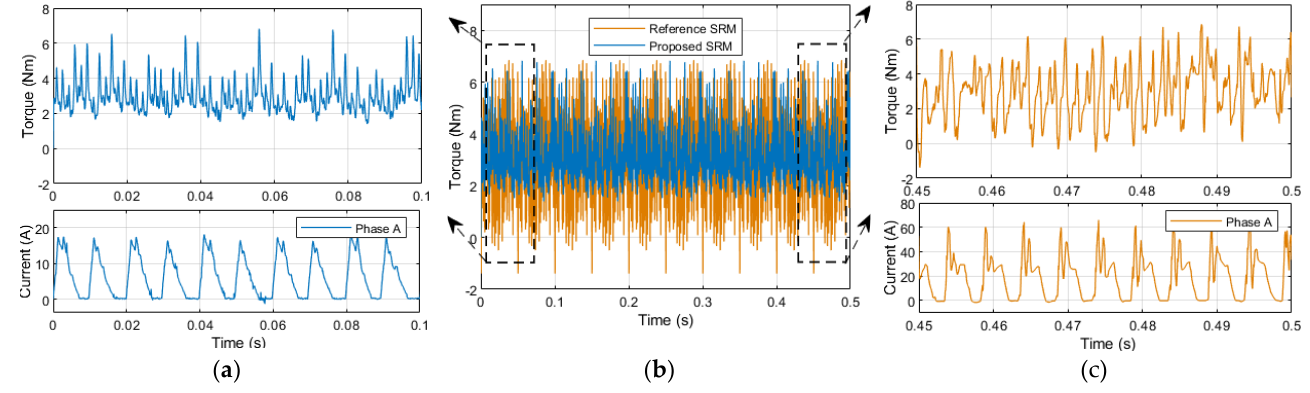
Figure 24. Torque reconstruction based on experiment results with 1500 rpm: ( a ) torque and current for the proposed SRM; ( b ) torque waveforms comparison; ( c ) torque and current for the reference conventional SRM.